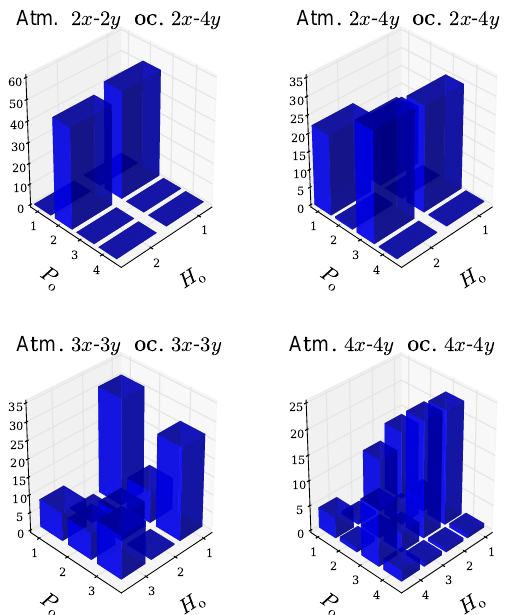
Figure 6. Variance distributions of the ψ o ,i variables in percents for various model resolutions (continued from Fig.